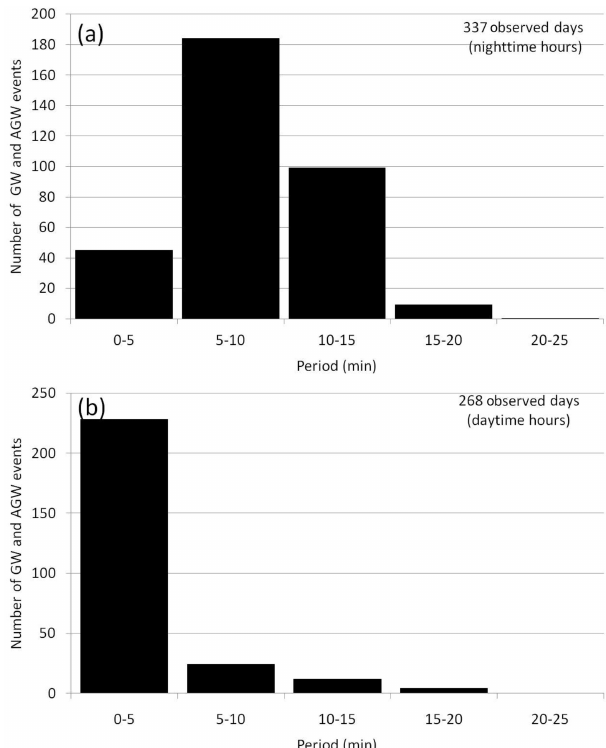
Figure 7. Histogram plots of the predominant observed wave pe- riods of the small-scale GWs detected in the lower portion of the ionosphere as amplitude variations of the VLF signal propagating in the NAA–EACF during night (a) and daytime (b)